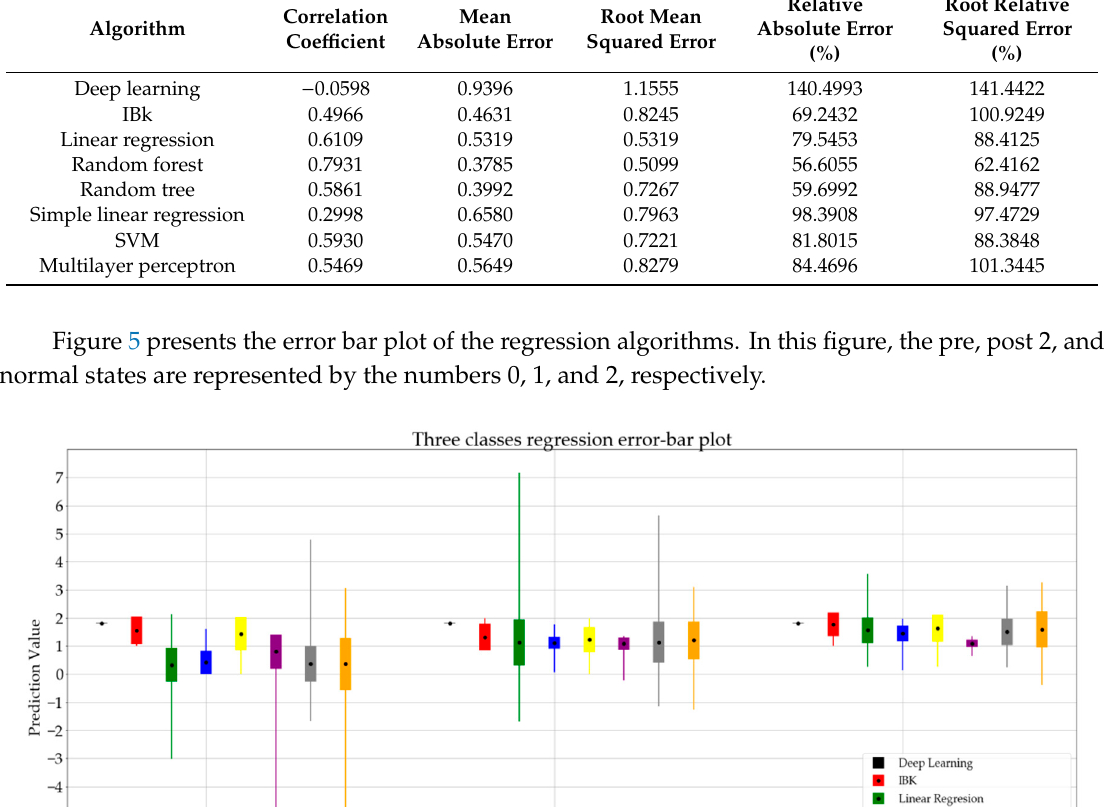
Algorithm Table 5. Error measures from eight regression algorithms classifying data into four classes.